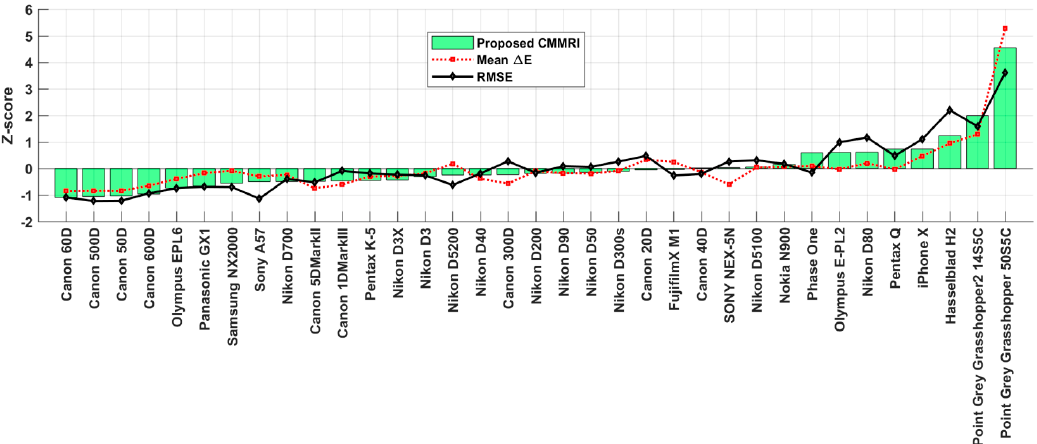
Figure 3. Plot of the corresponding z-scores of each of the three accuracy measures for each camera plotted in Figure 2. Low (including negative) z-scores are preferred.